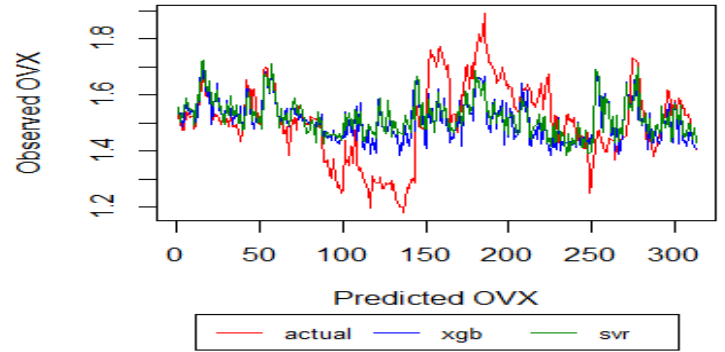
Figure 3. A plot of OVX forecasts before